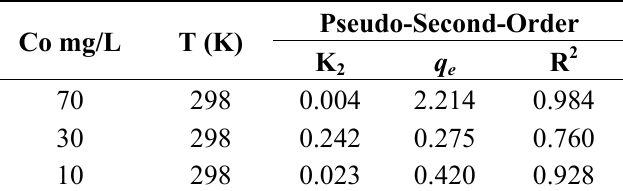
Table 2. Kinetic pseudo-second-order model parameters of the biosorption at various concentrations of composite